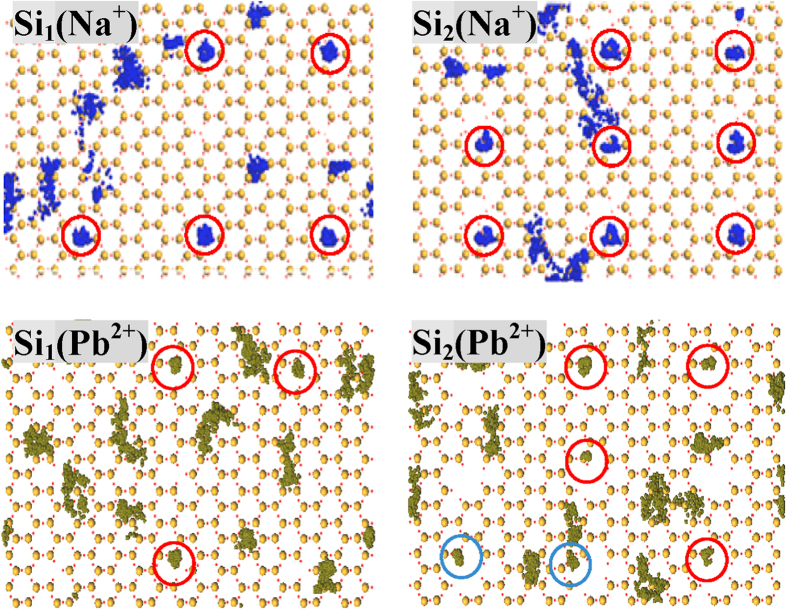
Trajectory maps of tetrahedral SiO4 surfaces of defective kaolinite (Si1 and Si2) in contact with 0.16 mol/L NaCl and PbCl2 solutions.Only the inner- and outer-sphere metal ions are made visible, and Na+ and Pb2+ ions are represented as blue and dark yellow balls, respectively. Inner- and outer-sphere metal ions that fall around the defective sites are highlighted by red and light blue circles, respectively.